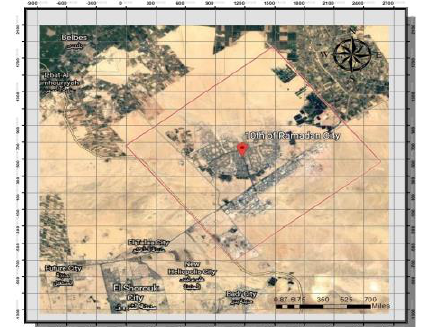
Figure 1 . Location for the area of